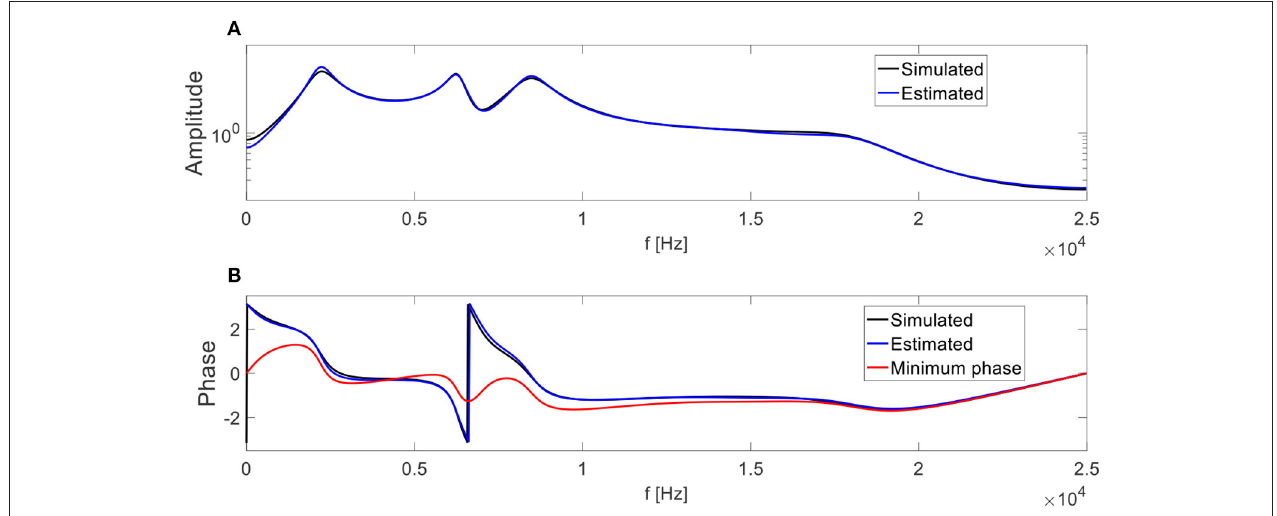
FIGURE 8 | The simulated transfer function and its estimations by the new technique (blue) and using a minimum phase assumption (red). The graph of the estimated transfer function by the new technique conceals some of the segments of the simulated transfer function. (A) Magnitude of the transfer functions, and (B) phase of the transfer functions. The ACS segment size was 50 bins. The degrees of the coefficients of the poles and zeros in the ARMA model were 10 and 5,